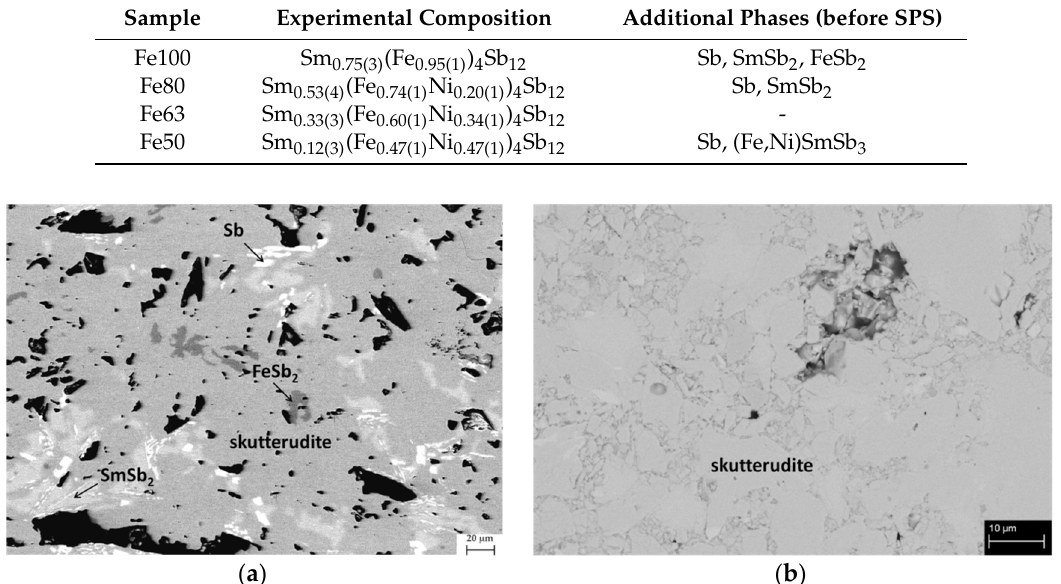
Figure 1. SEM microphotographs taken by backscattered electrons (BSE) on ( a ) Fe100_ann and ( b ) Fe100_SPS, respectively.